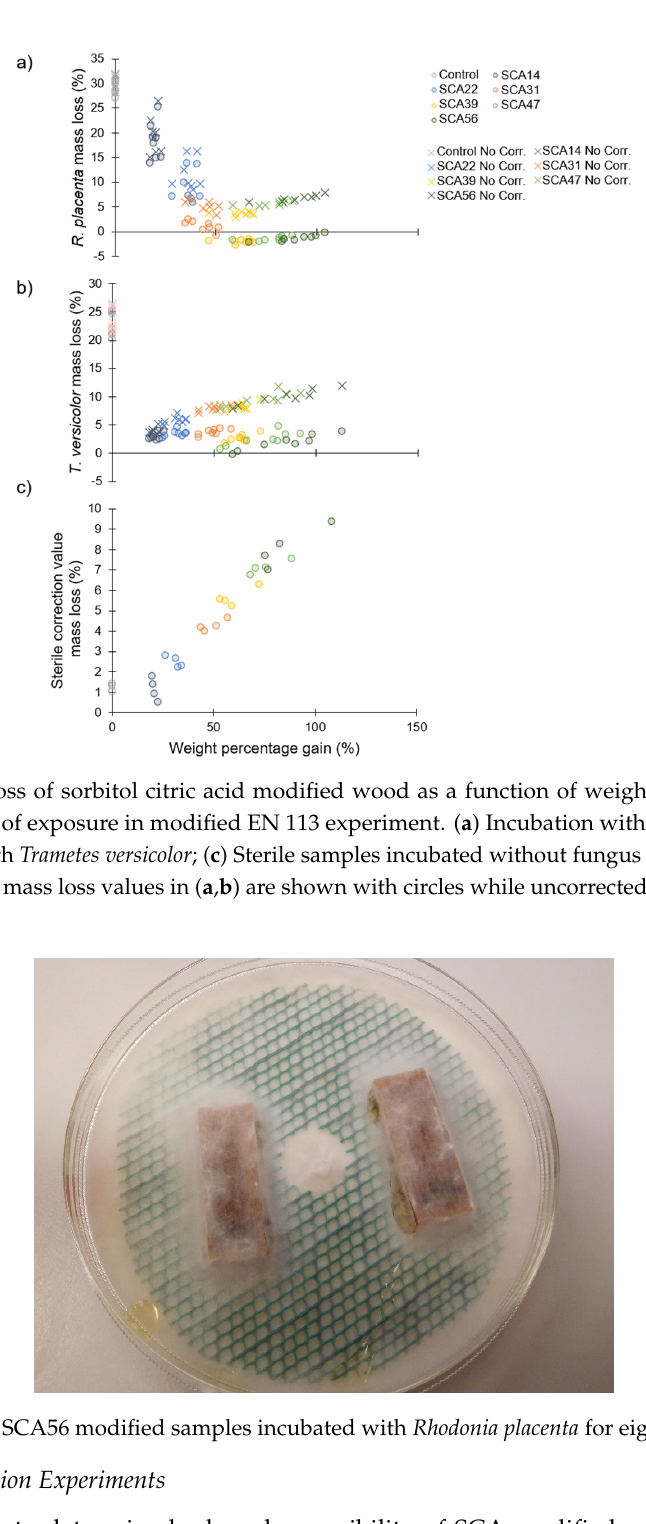
Figure 8. Sorption behaviour of pure SCA polymer. ( a ) Deuterium exchange experiment; ( b ) adsorption isotherm; Both measurements conducted at 25 °C. The solid green line shows sample mass and the dotted blue line shows relative humidity. Note the secondary y -axis and the broken primary y -axis. 4. Discussion The dimensions analysis results reported here (Figure 2) are in agreement with previous work on SCA-modified wood. In this study, the average bulking coefficient for SCA56 was 13.6% ± 0.5. With the same treatment concentration and curing temperature, Larnøy et al. [14] and Mubarok et al. [15] reported bulking coefficients of 11% and 15%, respectively. Mubarok et al. [15] modified European beech wood, so slightly higher values in their study may be explained by the difference in wood species. The bulking coefficient values indicate that the SCA polymerisation has occurred